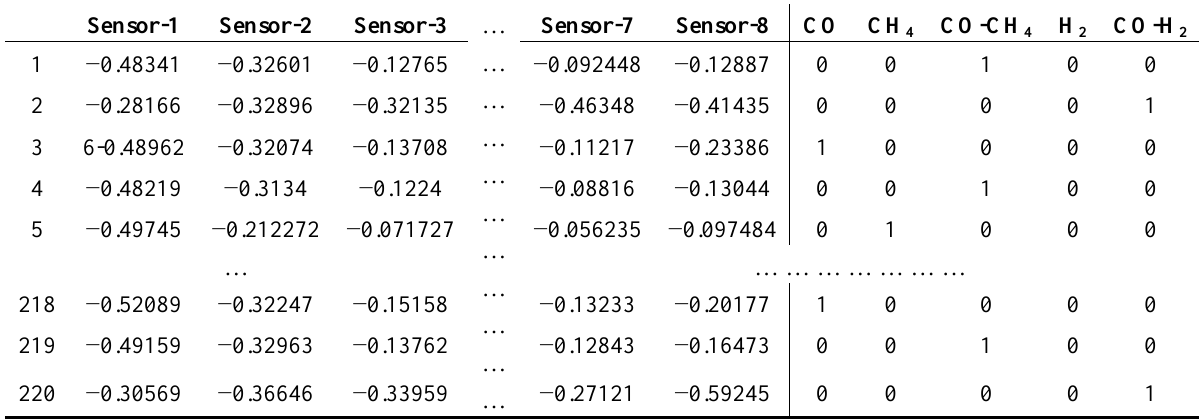
Table 4. The database. 8 Inputs Patterns 5 Outputs Class Labels